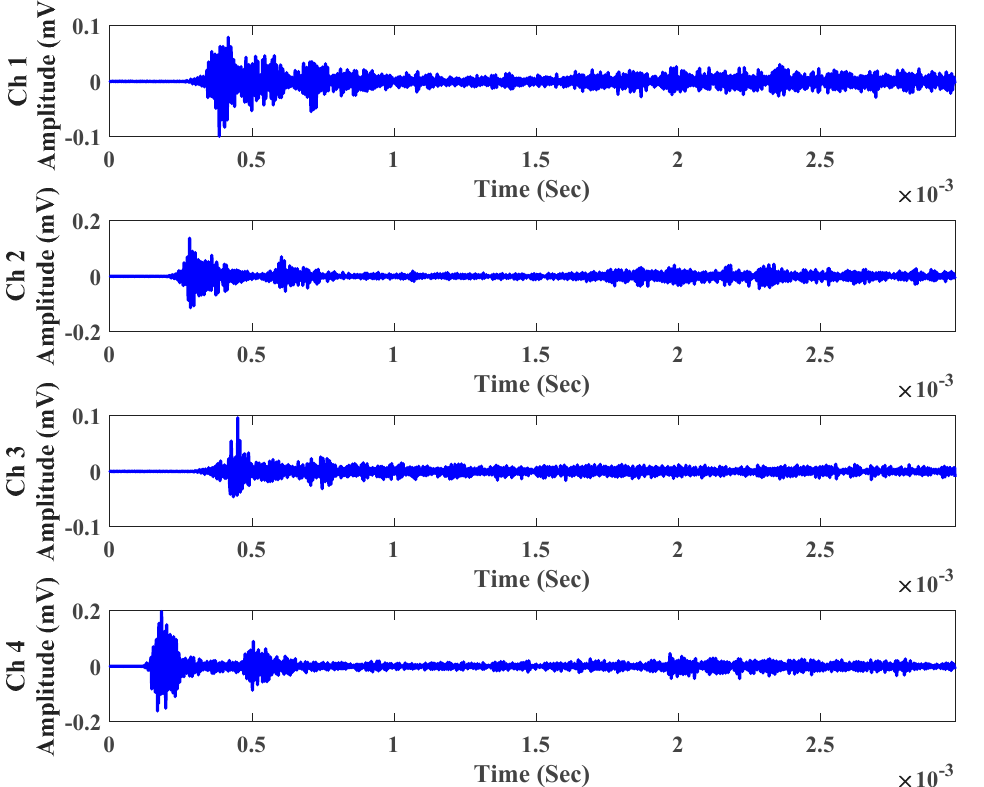
Figure 14. Acoustic emission signals obtained from the pencil lead break test (PLB) 3.